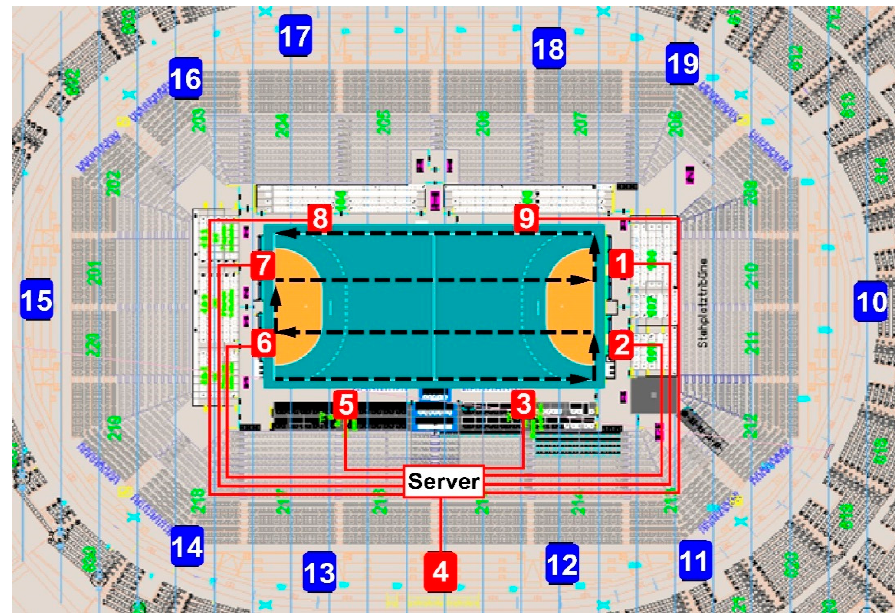
Figure 1. Local positioning system (LPS) setting: nine antennae connected to the server in red locations; ten reference antennae (anchors) in blue locations; meander path inside the field followed to check calibration accuracy (black discontinued line).